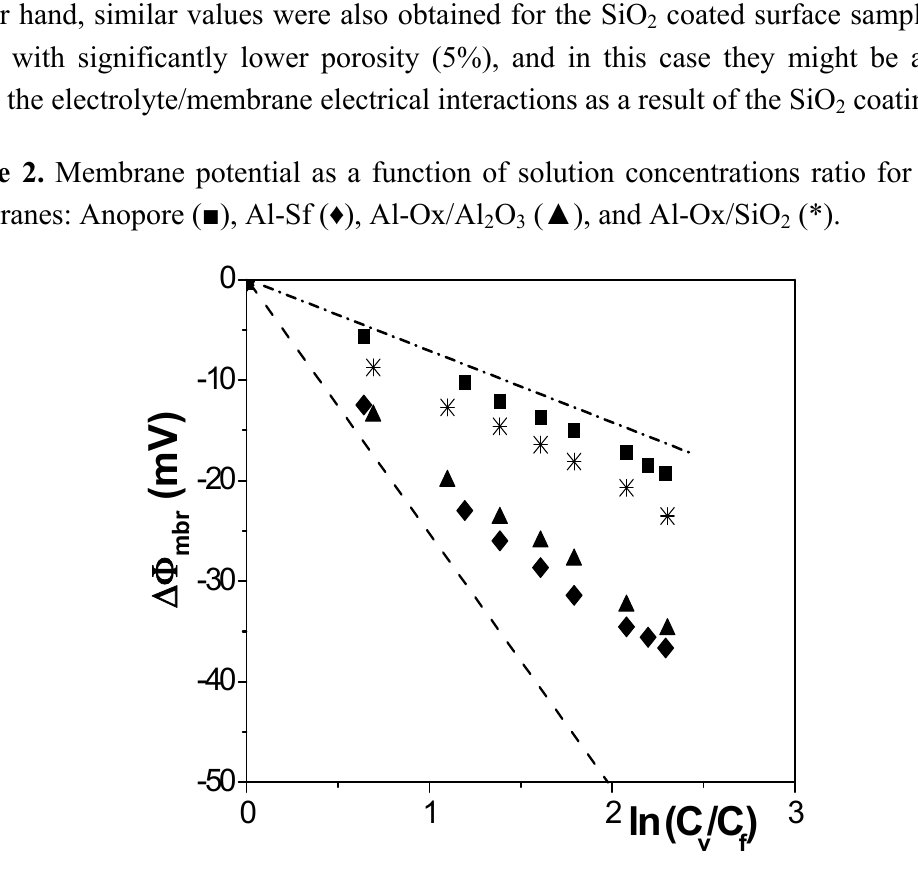
Figure 2. Membrane potential as a function of solution concentrations ratio for different membranes: Anopore (■), Al-Sf (♦), Al-Ox/Al